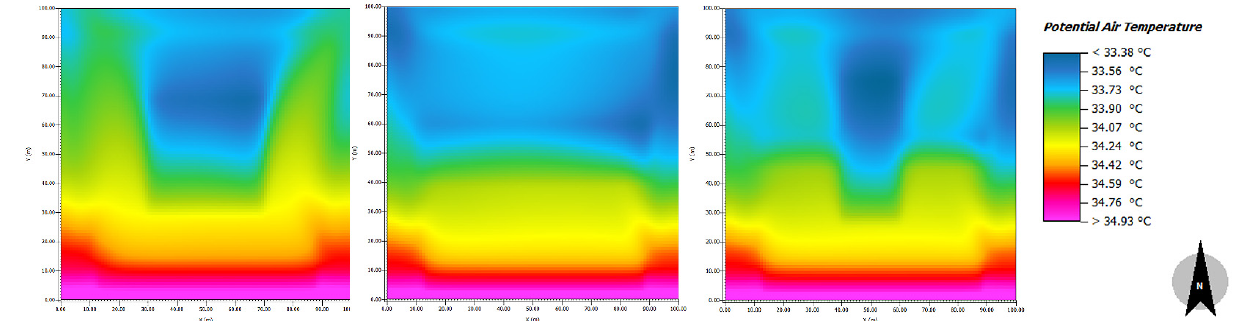
Figure 10. Average cooling effect and maximum cooling effect in cases 1, 5 and 6.